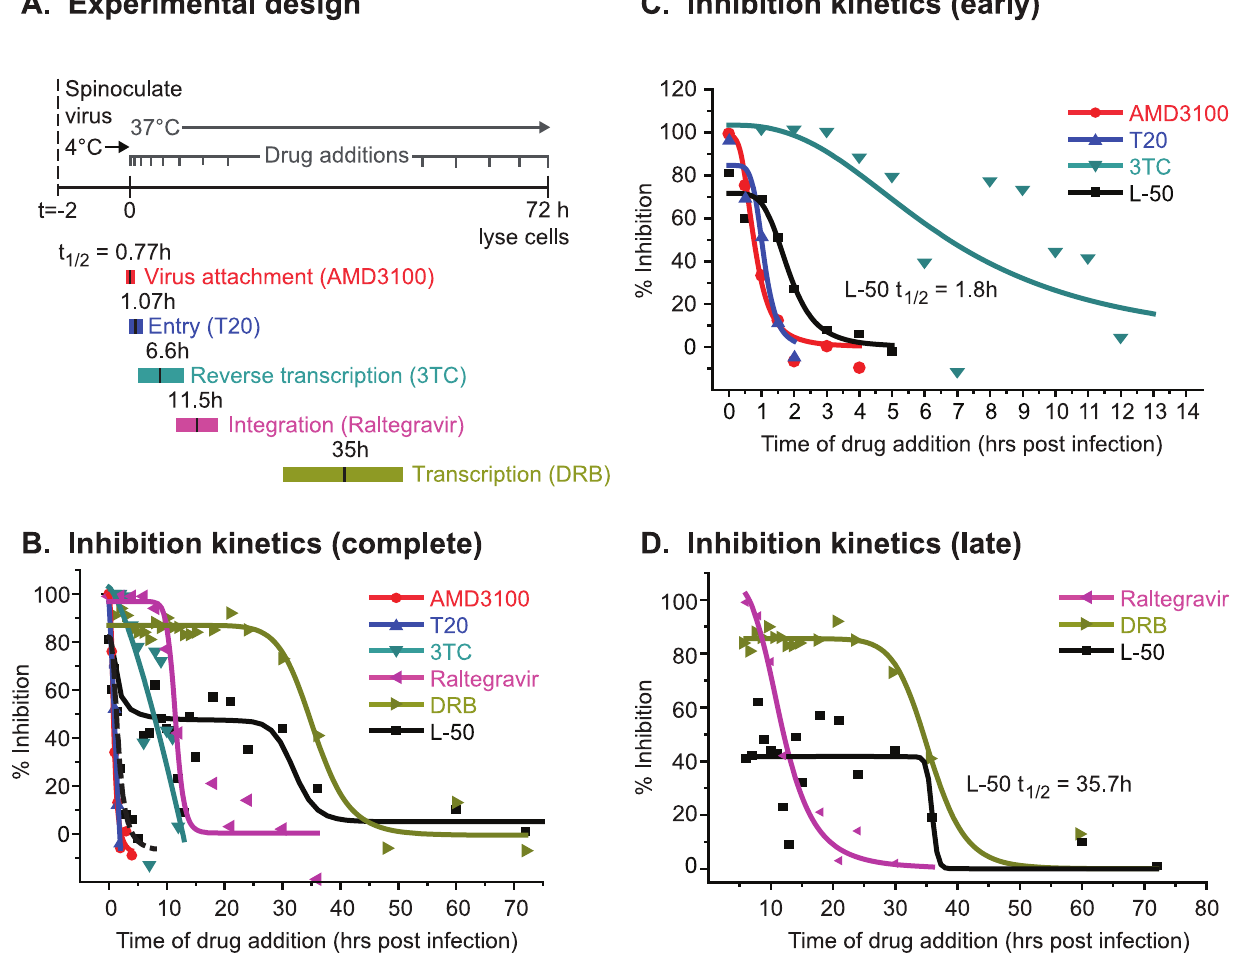
Figure 4. L50 effects on Tat-mediated transactivation of mRNA transcription in cell lines. ( A ) A schematic of the dual transfection of pNL4-3 and pcDNA.LUC (CMV) or pLTR-luc in 293T cells. Luciferase (in lysates) ( B ) and RT activity (in cell-free supernatants) ( C ) was measured 72 h following transfection/drug treatment of 293T cells. Supernatant from 293T transfections conditions were used to infect U87.CD4.CXCR4 cells. ( D ) Virus production at 10 days post infection was measured by RT activity.